Question: Based on the figure, does the quantity rise or fall?
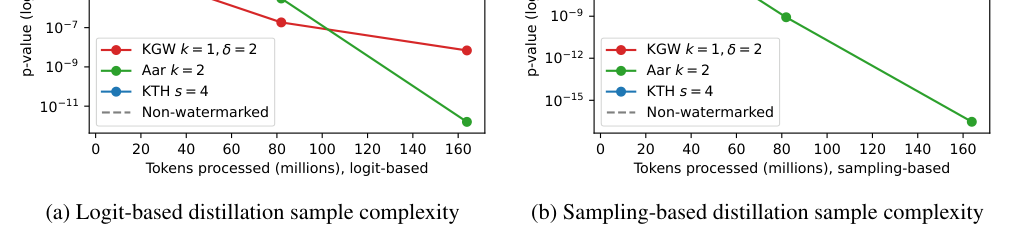
Answer: increasing